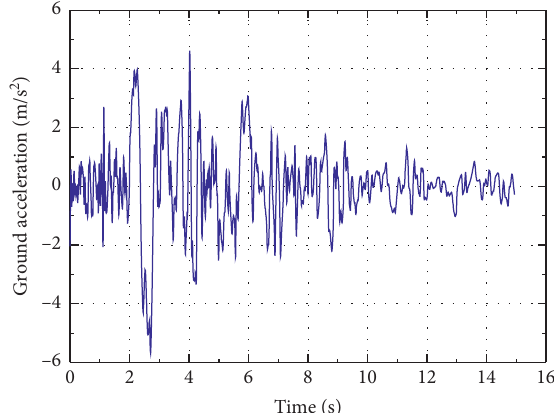
Figure 4: Ground acceleration time history of LA16 record.